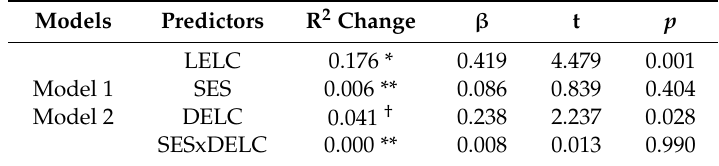
Table 7. Results of the hierarchical regression analyses on narrative comprehension (TOR). R 2 = 0.22.